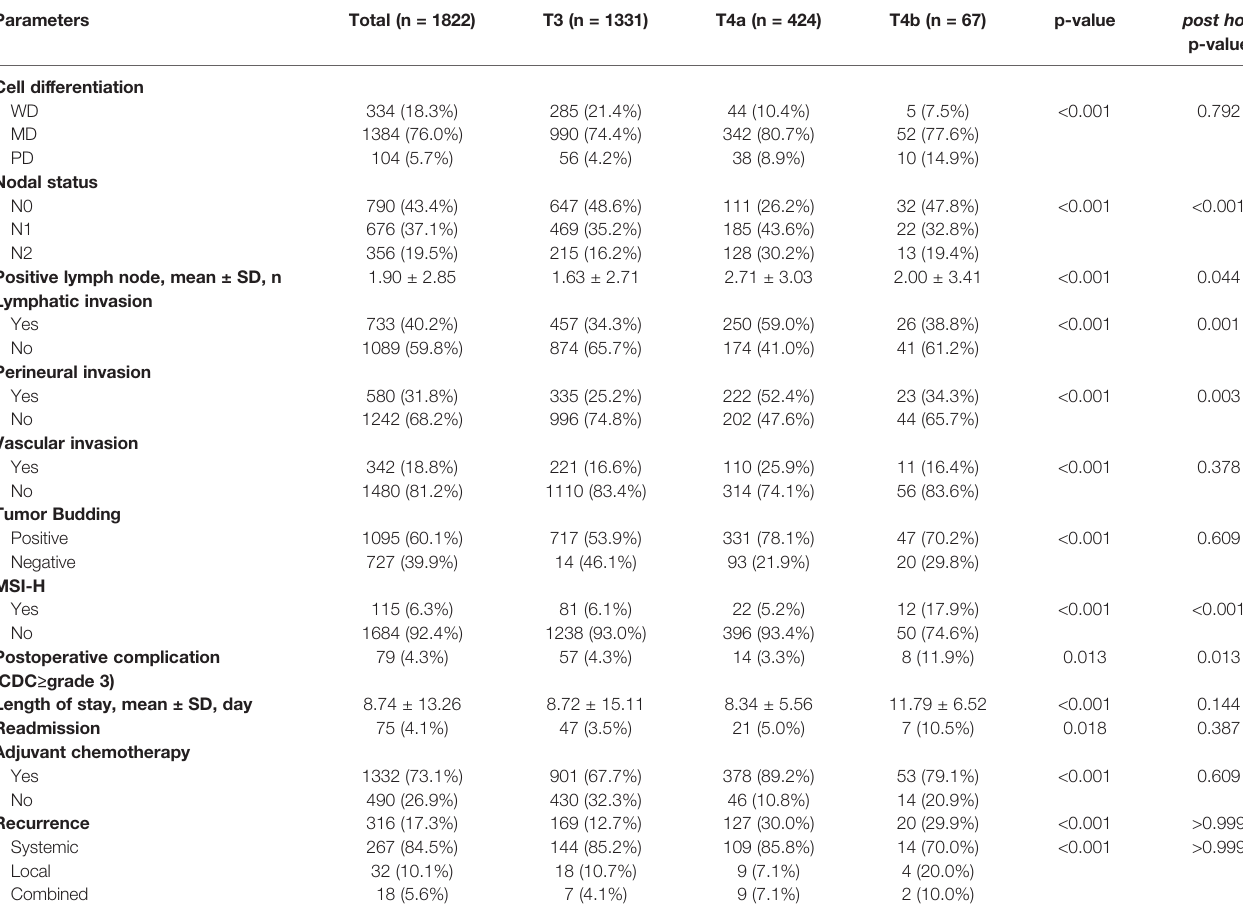
TABLE 2 | Postoperative